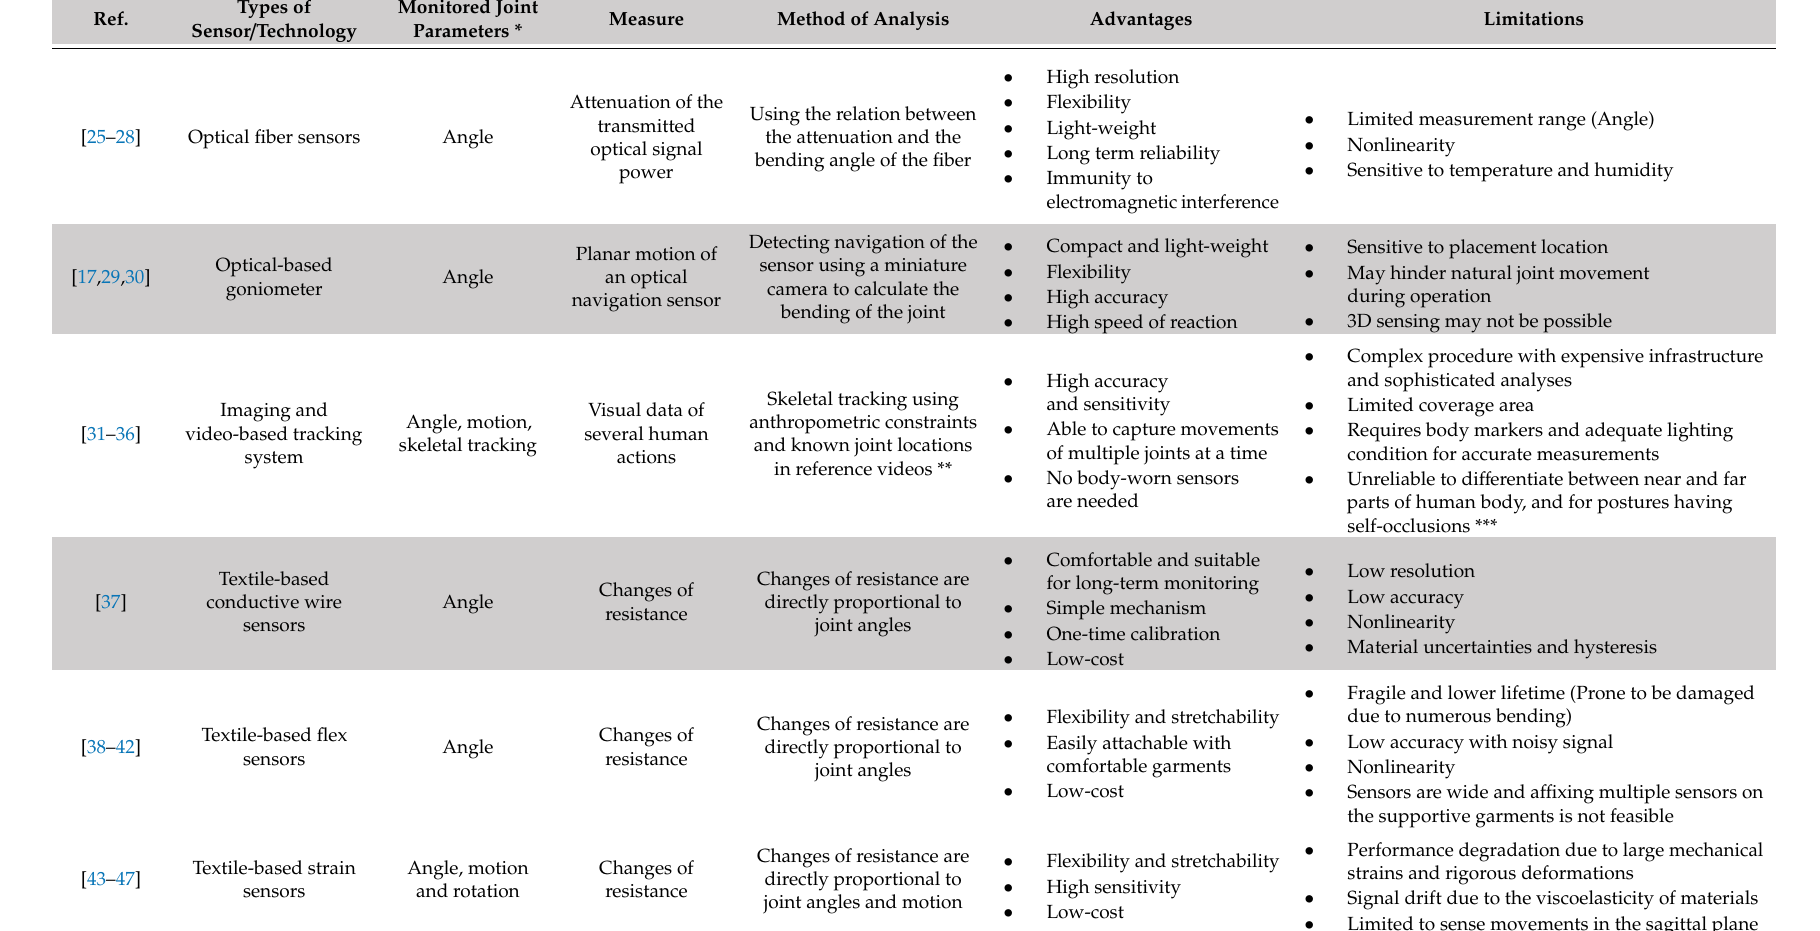
Table 2. Comparison among di ff erent published sensor technologies for monitoring